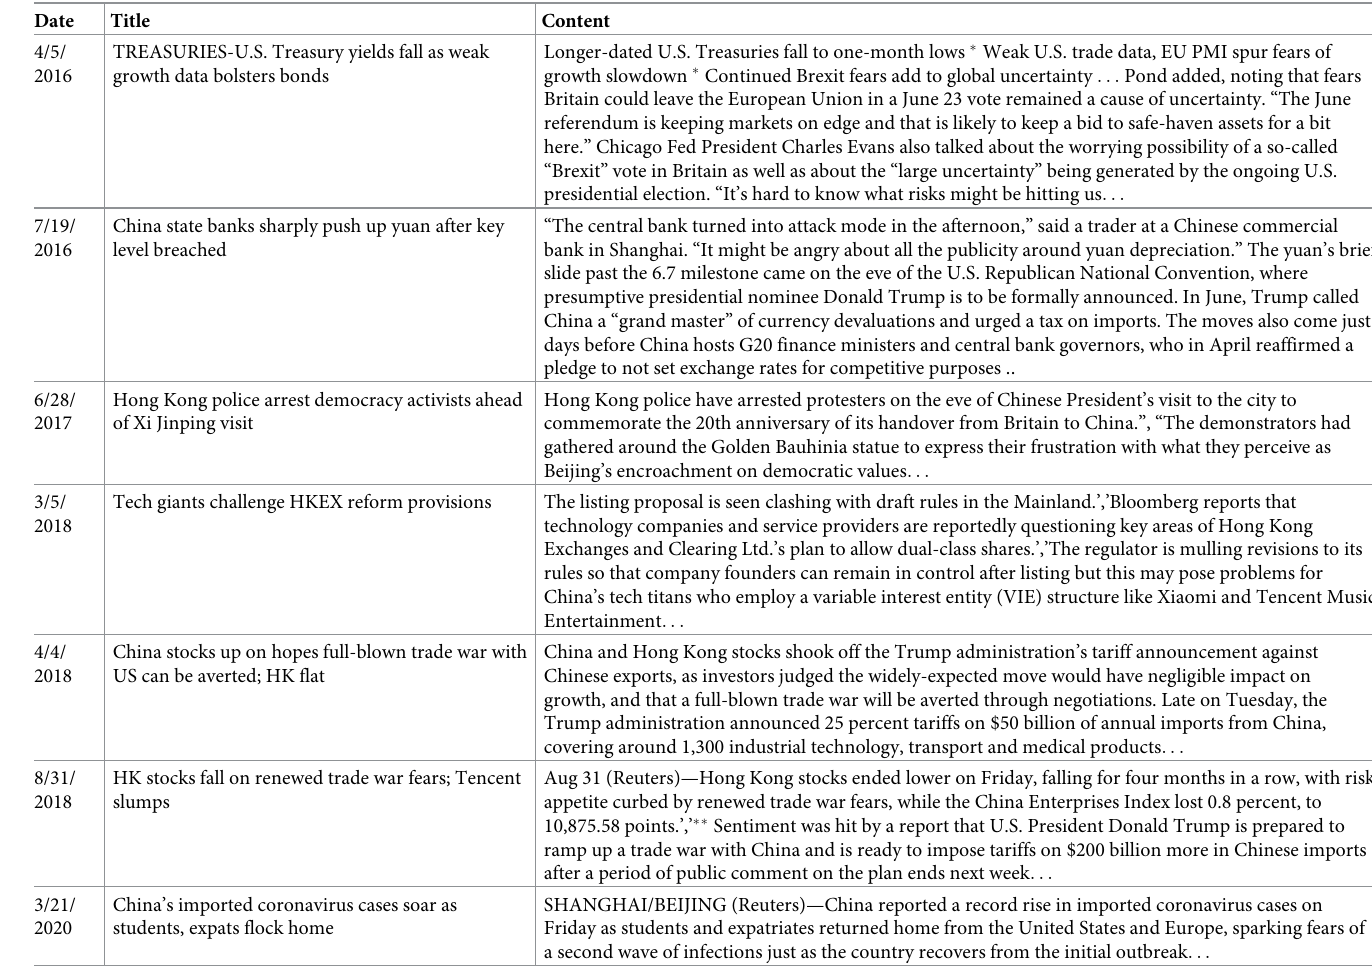
Table 1. Examples of news information collected from open